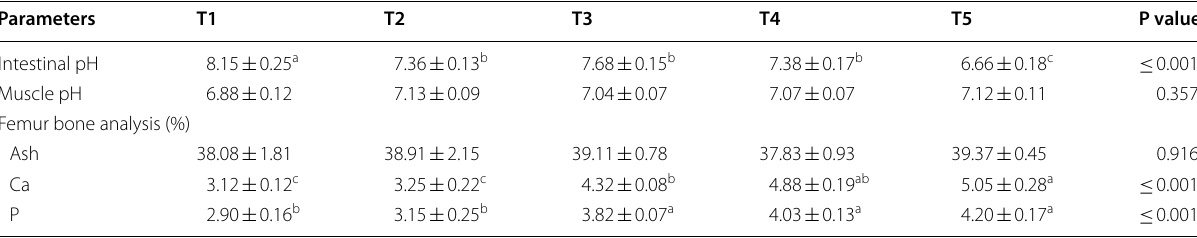
Table 5 The effect of graded levels of whey with addition of citric acid on intestinal and muscle PH, and femur bone anal- ysis on fresh basis